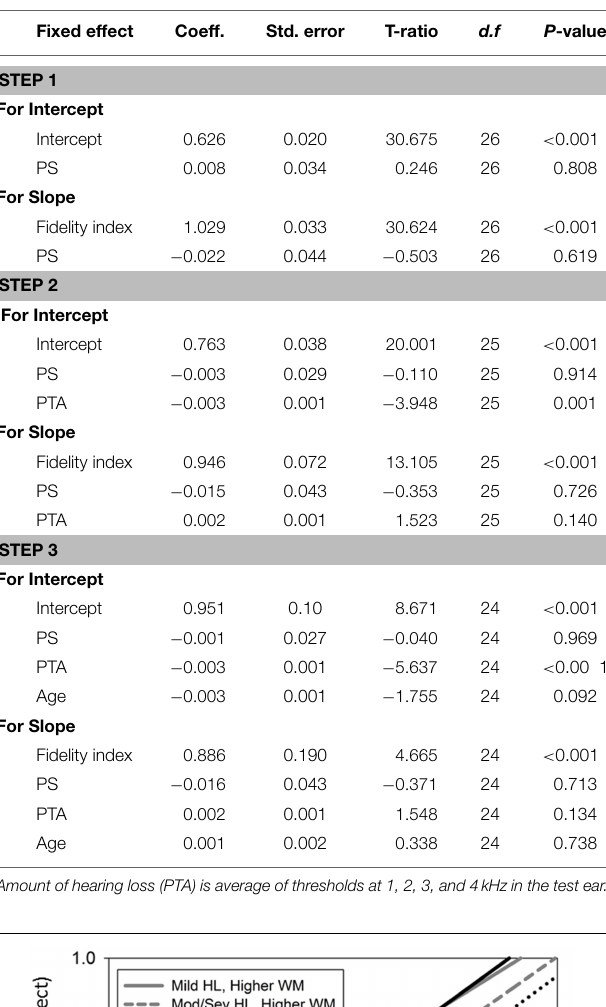
average quality ratings as a function of the envelope fidelity met- ric. Each processing combination is indicated by data point label- ing, and signal-to-noise ratio is indicated by symbol